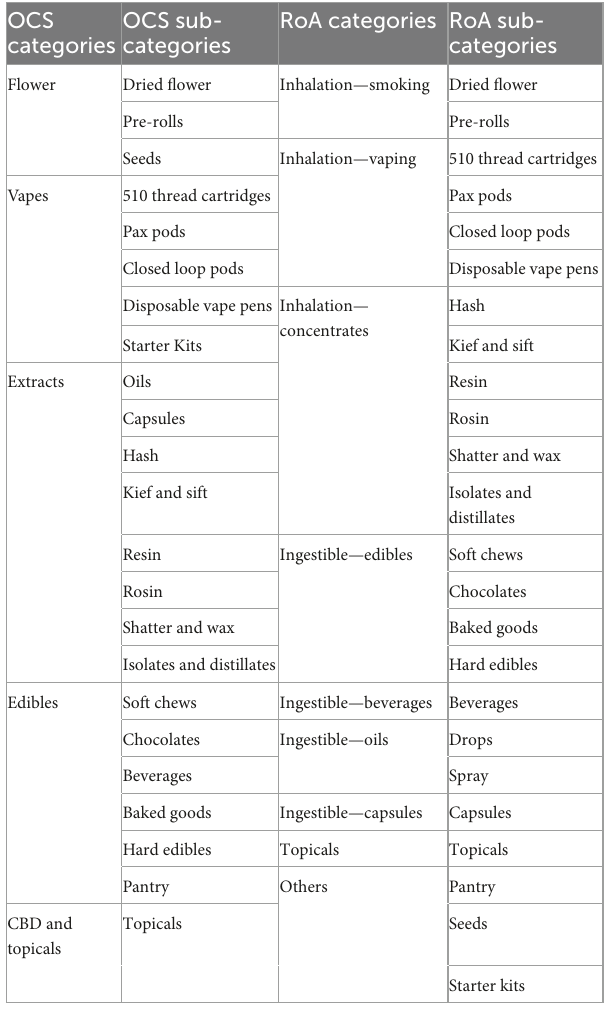
TABLE 1 Ontario cannabis store (OCS) product categories and sub-categories mapped by route of administration